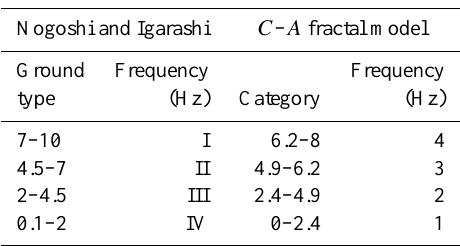
Table 4. Comparison of frequency separation by C – A fractal model and Nogoshi and Igarashi (1970,